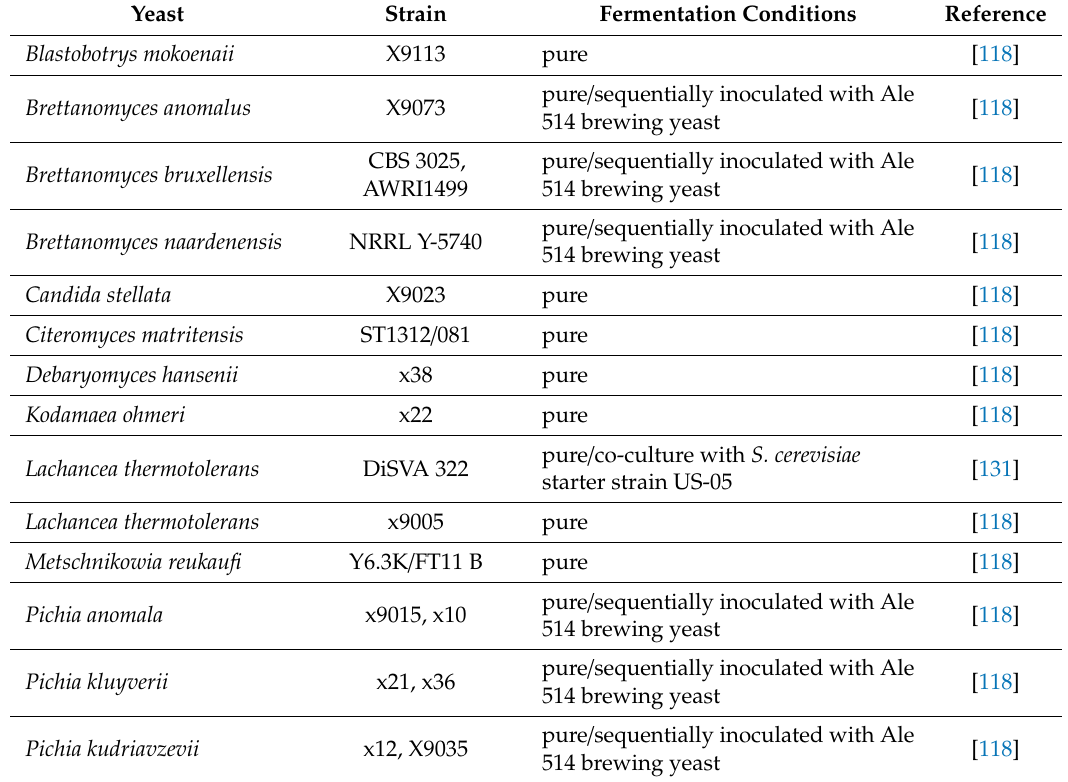
Table 2. Main non- Saccharomyces yeasts used in beer production and their brewing conditions. Yeast